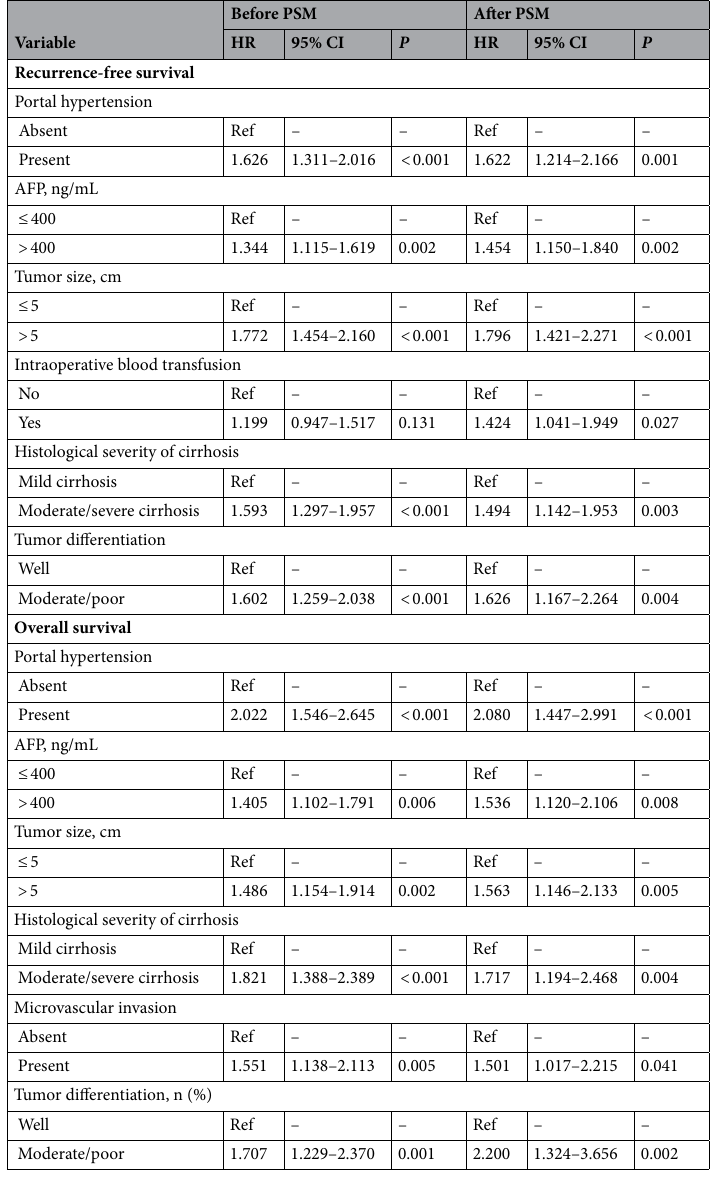
Table 5. Independent prognostic factors for recurrence-free and overall survival by multivariate analysis. PSM propensity score matching, HR hazard ratio, CI confidence interval, AFP